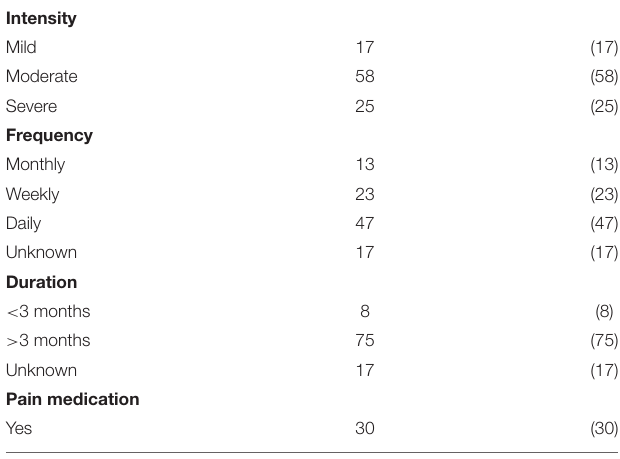
TABLE 3 | Pain characteristics ( n =